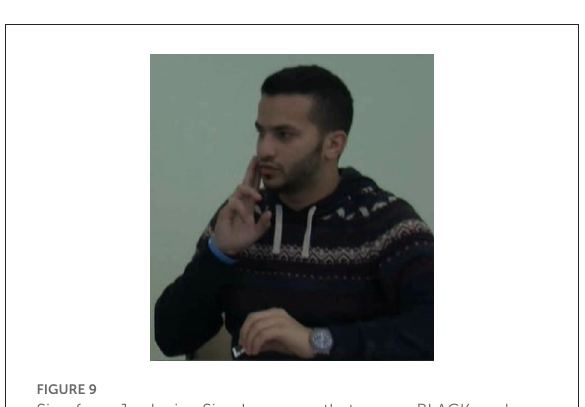
FIGURE9 Sign from Jordanian Sign Language that means BLACK, and makes use of visual indexical motivation referring to a